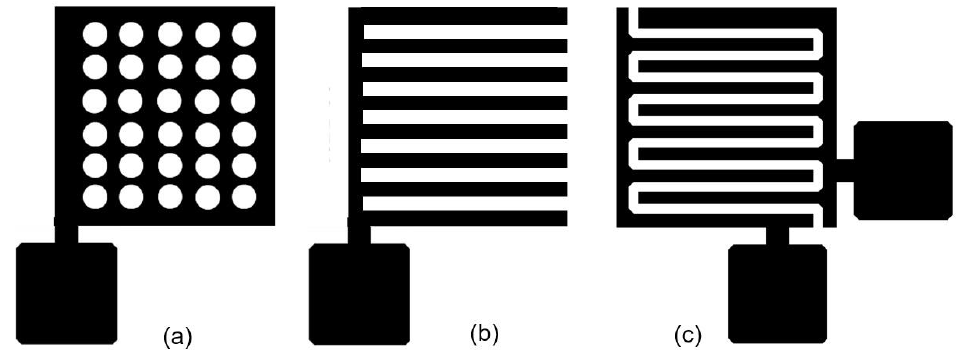
Figure 12. Possible configuration of electrodes in capacitive humidity sensors: ( a , b ) — perforated electrodes in parallel plate capacitive humidity sensors, ( c ) interdigital electrodes in coplanar capacitive humidity sensors. Adapted from [229]. Published 2014 by MDPI open access.